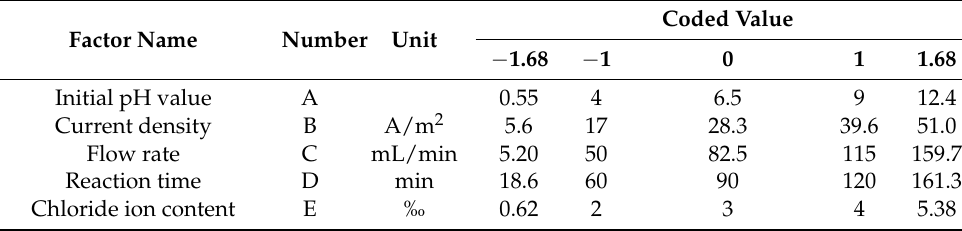
Table 1. Actual value and code value correspondence